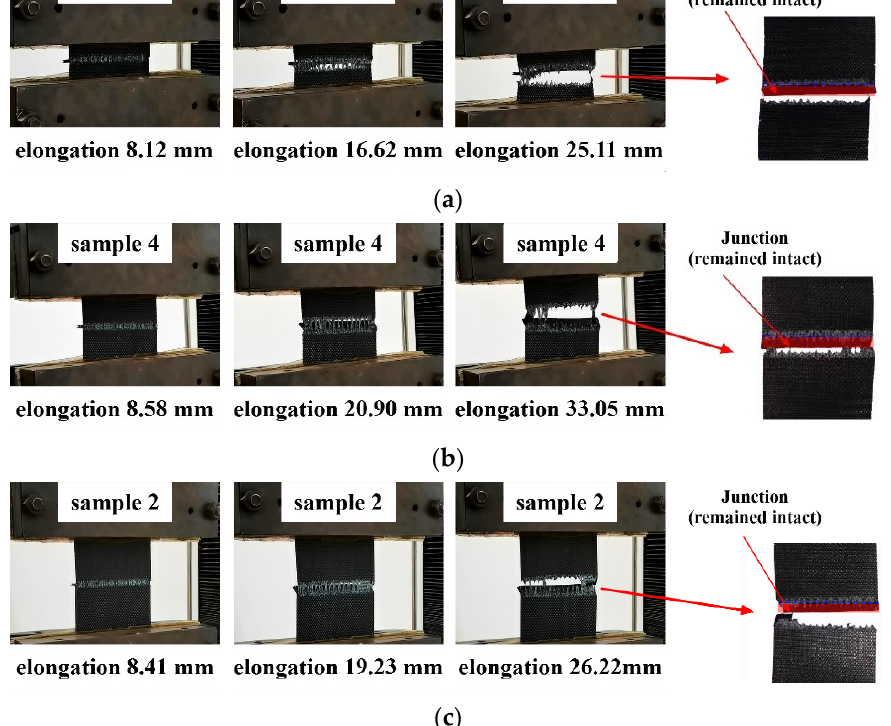
Figure 14. Failure modes of the junction subjected to a peeling force under various clamping distances: ( a ) 25 mm, ( b ) 50 mm, ( c ) 100